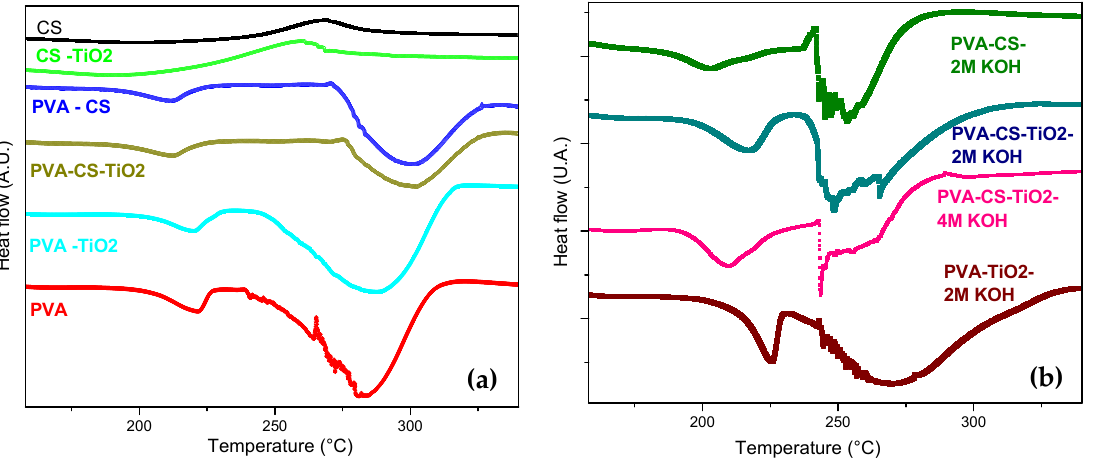
Figure 5. DSC curves for the compound and its precursors: ( a ) undoped; ( b ) doped with KOH.